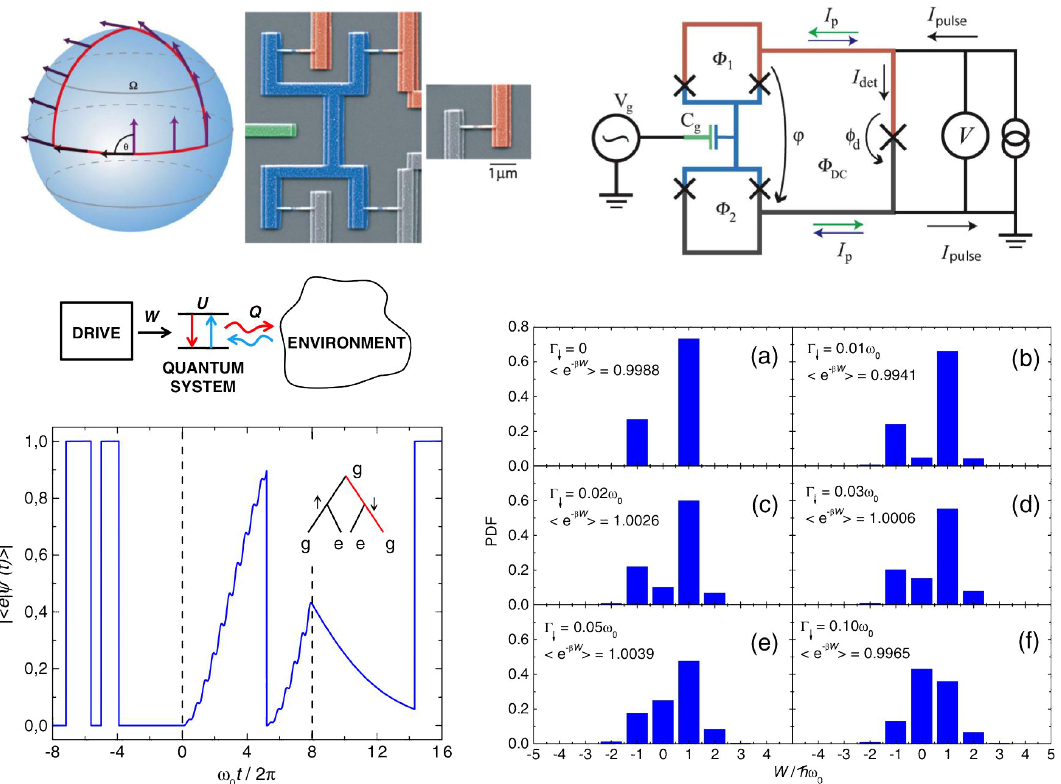
Figure 4: Top, from left to right [ 41 ] : Parallel transport of a vector along a path (red line) enclosing a solid angle Ω . The light arrow shows the initial state of the vector and the dark arrow the final state. The angle between the initial and the final vectors θ is equal to Ω . Scanning electron micrograph of the actual structure mea- sured: island on the left and the detector on the right. Simplified circuit diagram of the measured sample. The corresponding parts in the circuit diagram and SEM- images are marked by colors. Middle: Quantum jump approach to study stochastic thermodynamics of an open quantum system [ 51 ] . A schematic representation of an open quantum two-level system exchanging energy via photon emission / absorption to / from the heat bath. Bottom left: a typical time evolution of the stochastic wave function (population of the excited state) when the qubit is driven. Quantum jumps are seen as abrupt changes of the population. Bottom right: extracted work distribu- tions of the driven qubit based on the quantum jump approach. Different panel cor- respond to different decay rates of the qubit. In all cases the central non-equilibrium fluctuation relation (Jarzynski equality) is satisfied within the numerical